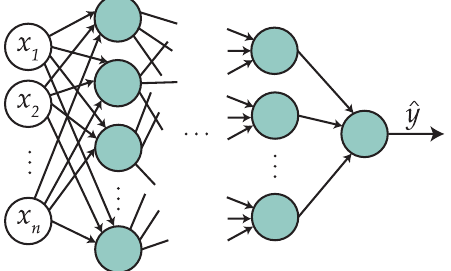
Figure 2. Basic topology of a multi-layer